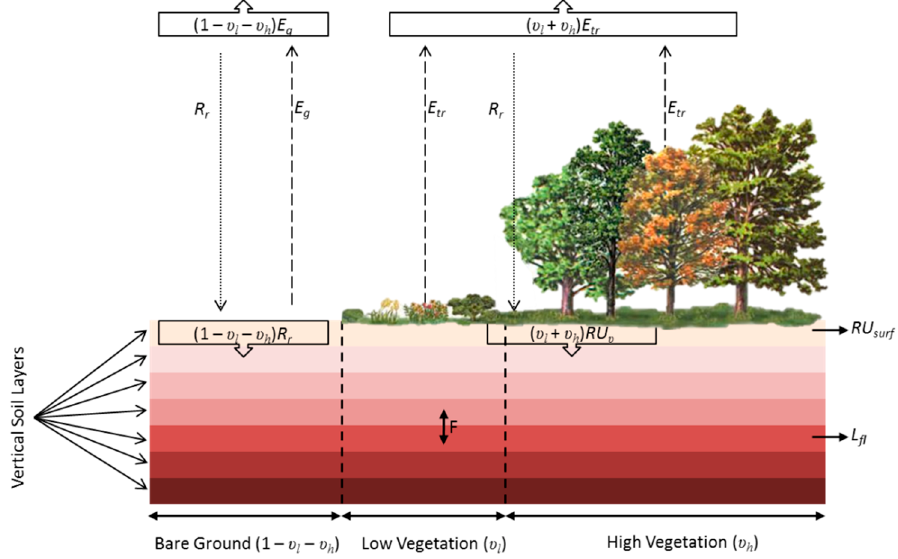
Figure 4. Representation of the hydrological process in the soil, vegetation, and snow (SVS) model.